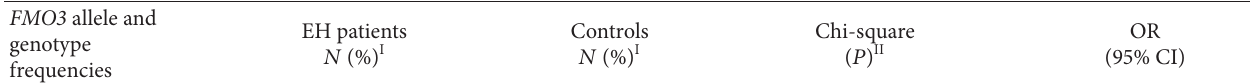
Chi-square ( 𝑃 ) II